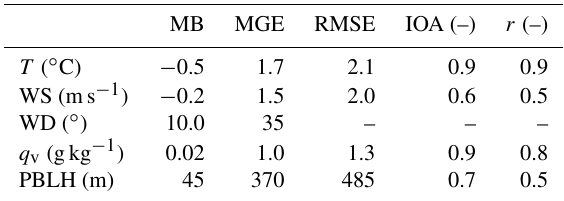
Table 4. Model performance evaluation for the meteorological pa- rameters in summer (JJA)